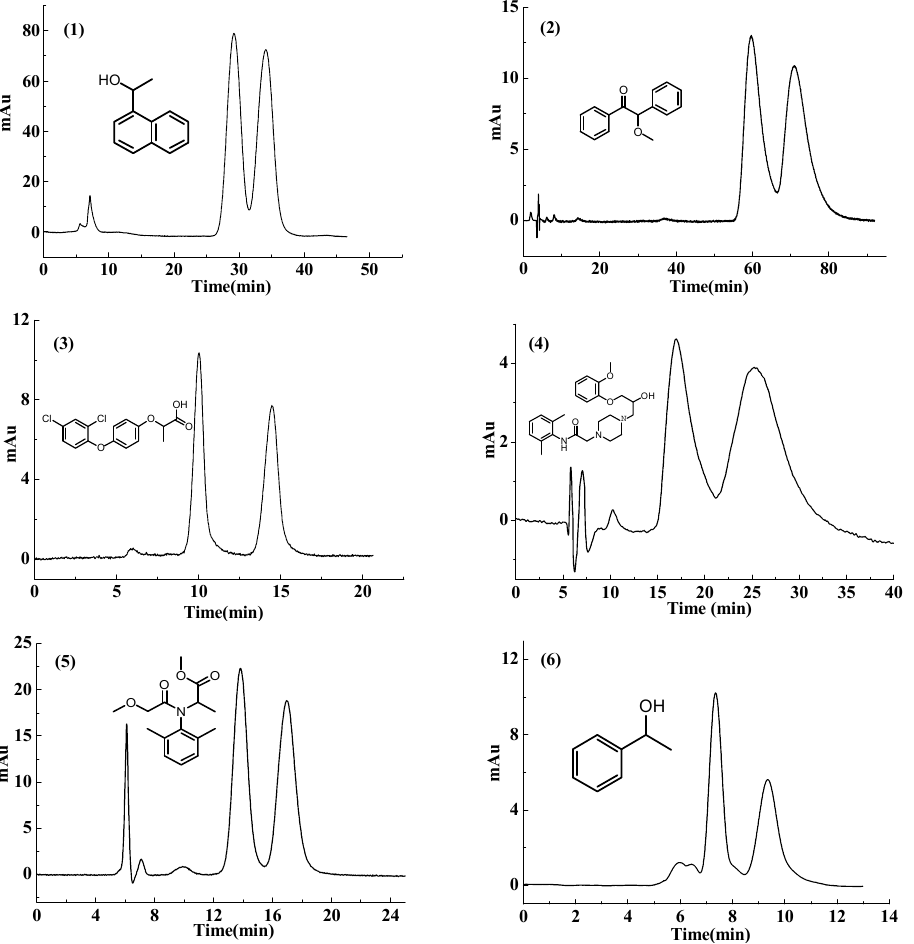
Figure 3. Chiral separation chromatograms of racemates on CPM2 column under normal